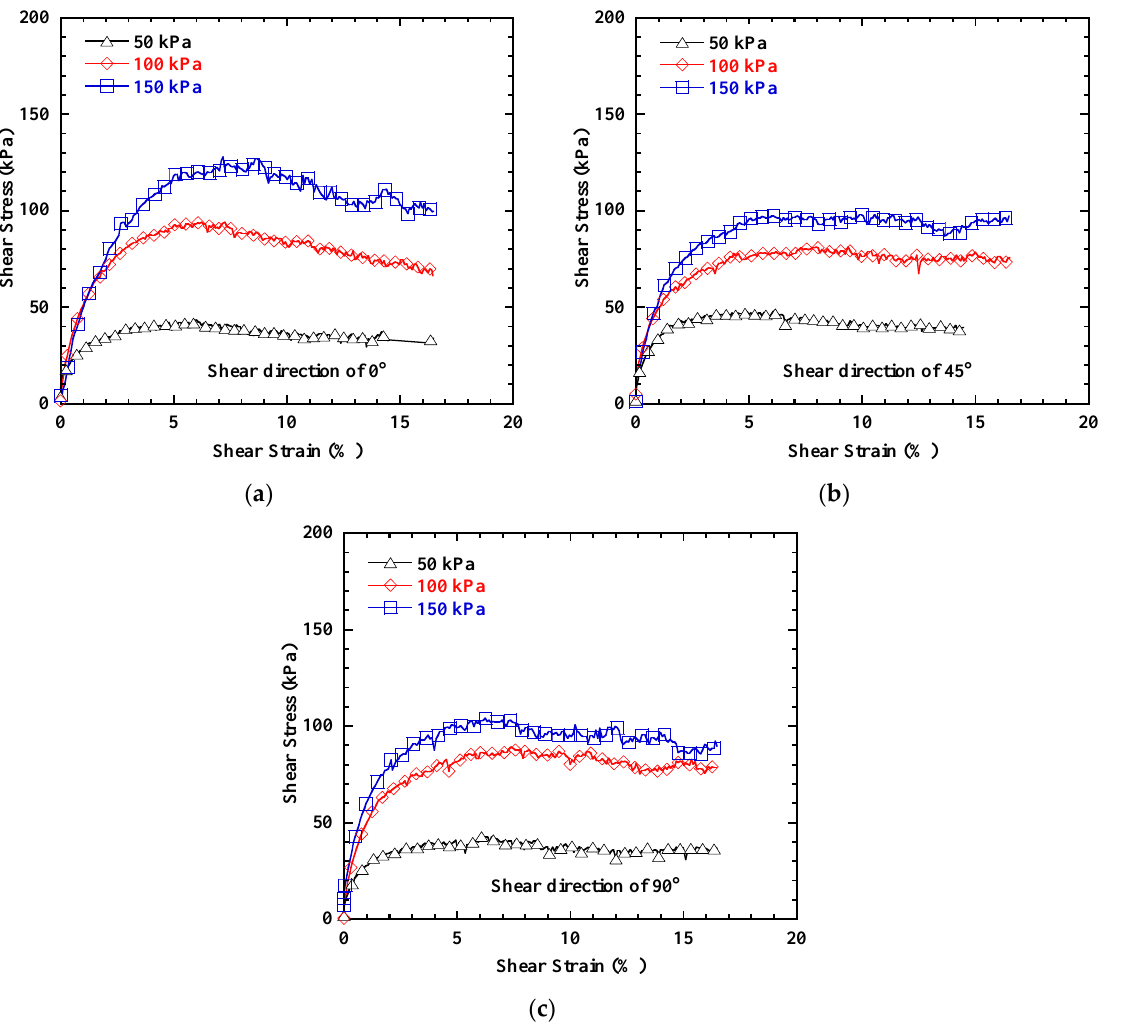
Figure 9. Shear stress–strain curves for coarse sand–biaxial geogrid (SS40) interfaces. ( a ) Shear direction of 0 ◦ , ( b ) shear direction of 45 ◦ , ( c ) shear direction of 90 ◦